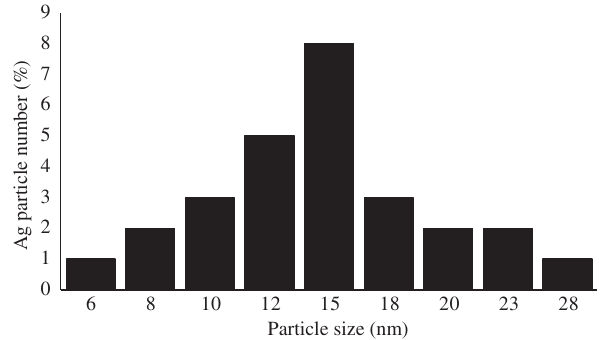
Figure 6: Particle size distribution under optimized conditions. The particle size distribution revealed that the particles ranged 15 nm had the maximum intensity, and thereafter the intensity was reduced. The average particle size was found to be 14.77 ± 0.25